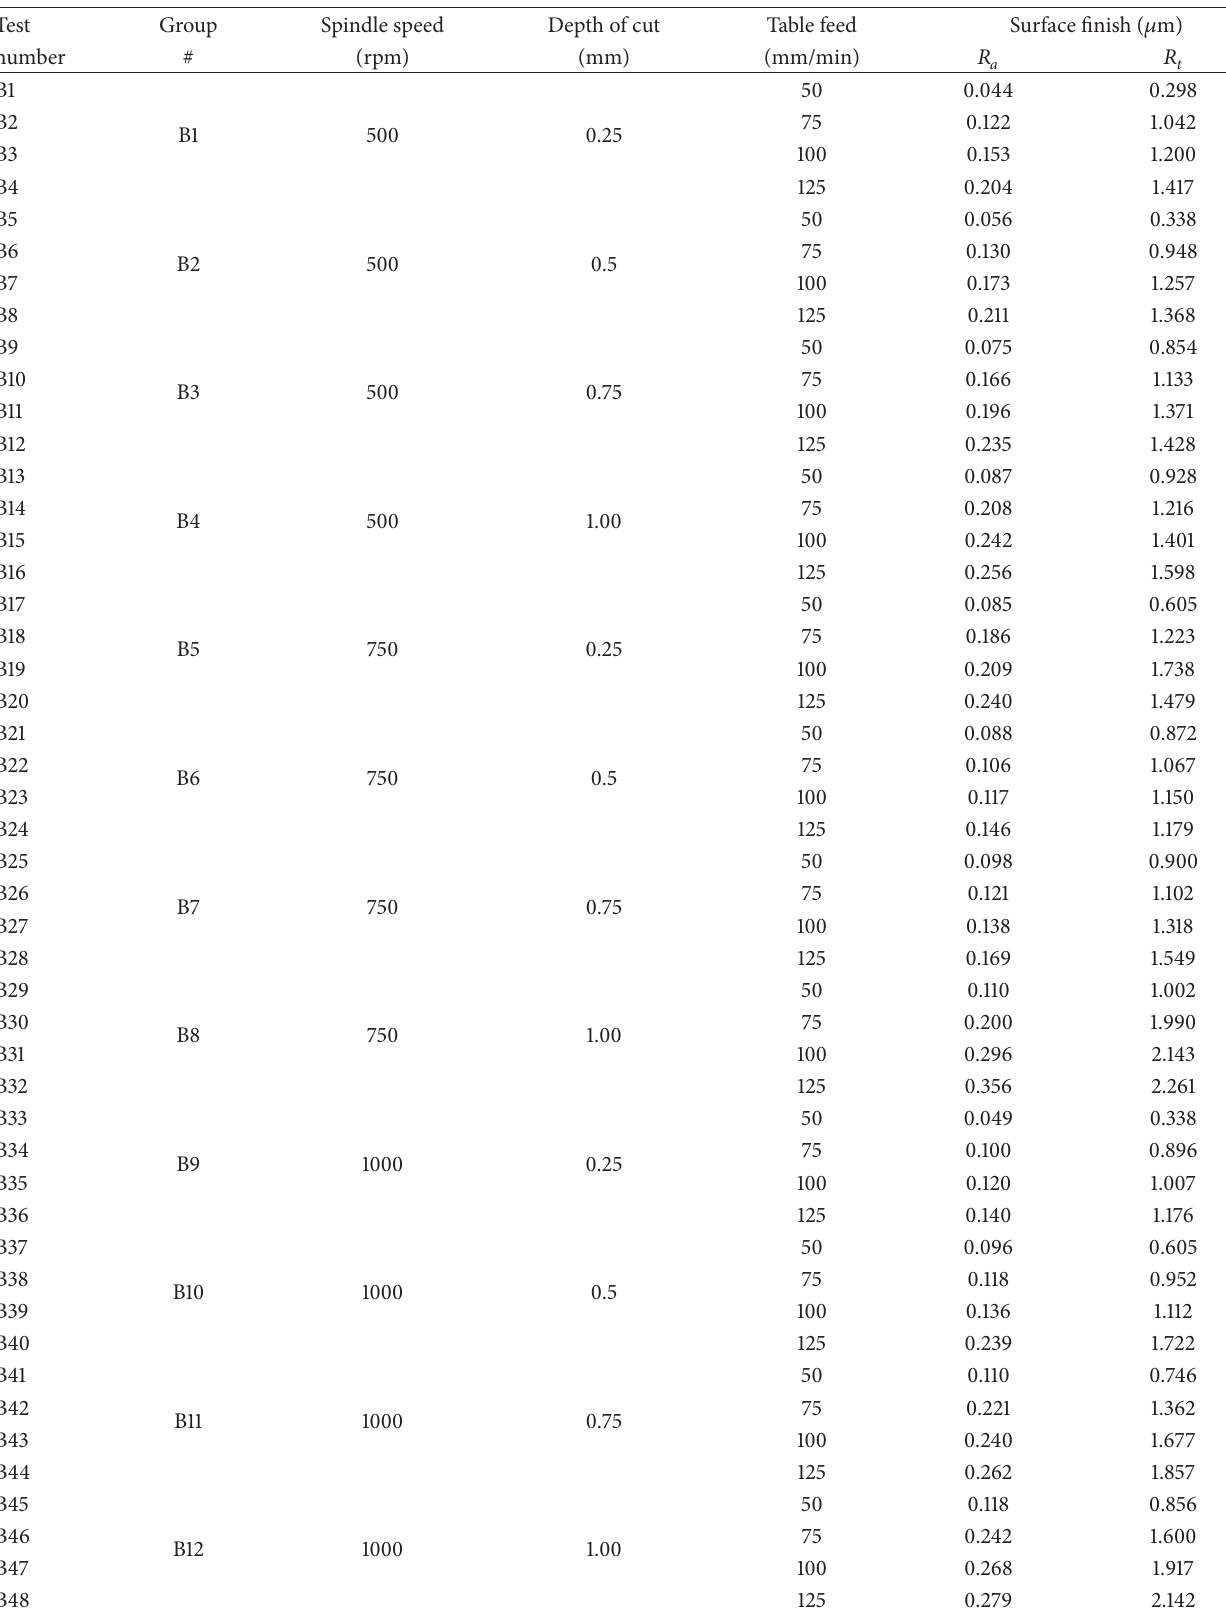
Table 7: Cutting conditions for group